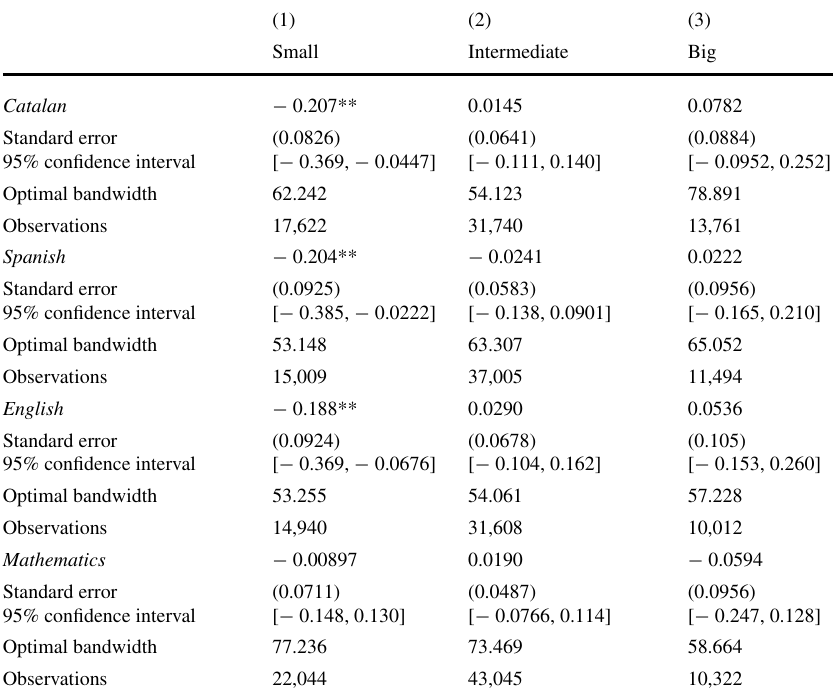
Table 9 Diff-in-disc regression results by school